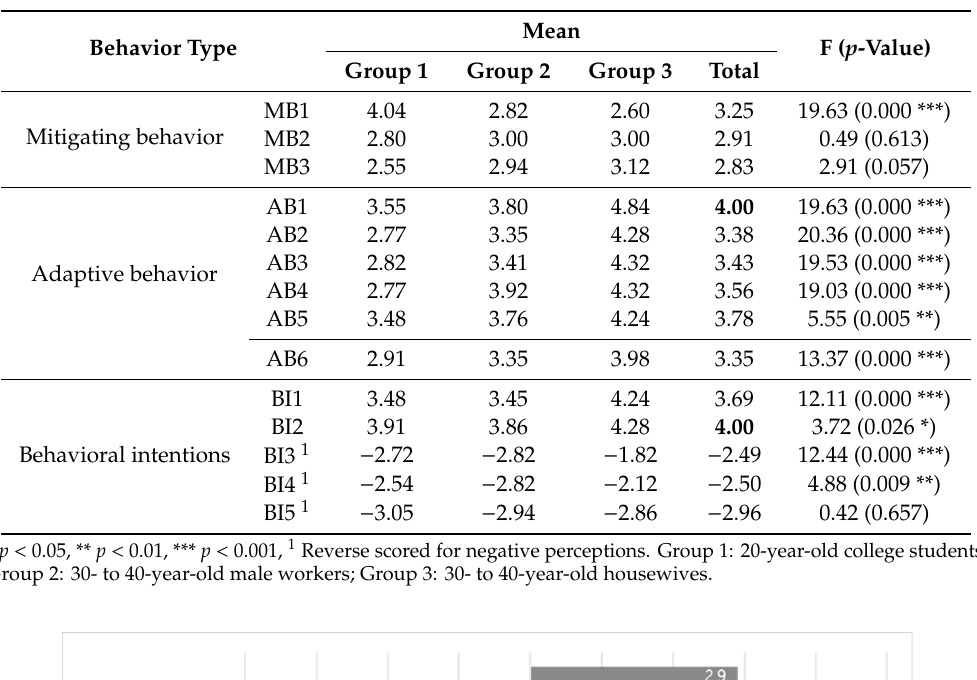
Table 9. Residents’ response behaviors to particulate matter.